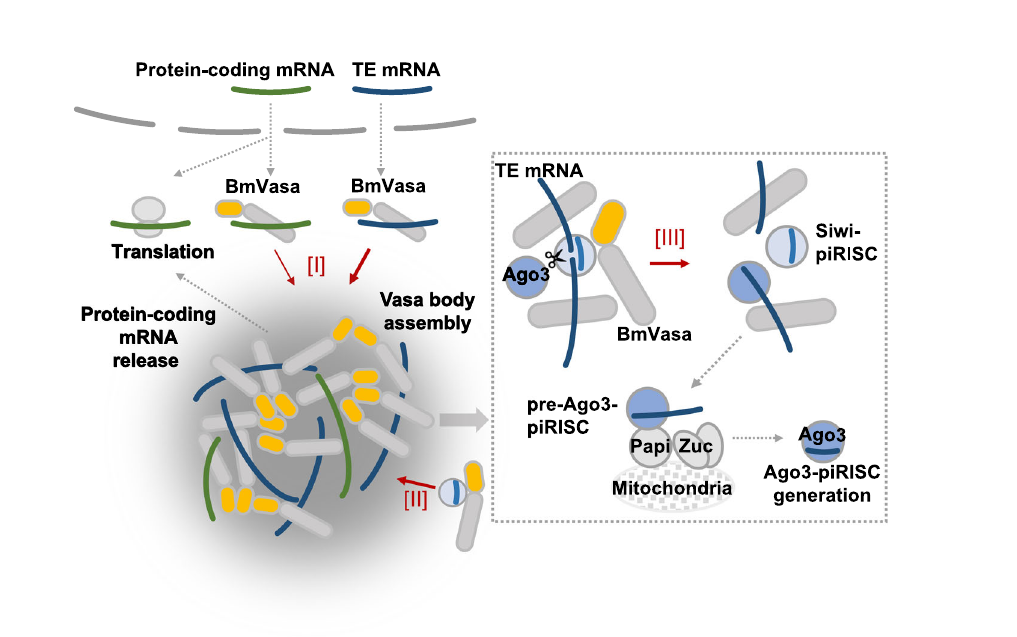
Fig.5|BmVasapreferentiallybindstotransposonmRNAsinvivo.a , b Piecharts show the proportions of transposon mRNAs (blue) and protein-coding mRNAs (green) in the total RNA sequencing library (Total; left) and in the BmVasa FAST- iCLIP library (BmVasa binding; right), both of which were individually produced in BmN4cells(Control)( a )andinBmN4cellslackingSiwi-piRISC(Siwi-piRISCKD)( b ). The association between the data is statistically signi fi cant (X 2 =56,205, df = 1, p value <2.2×10 − 16 , by Pearson ’ s chi-squared test (Two-tailed)) ( a ), (X 2 =60,140, df=1, p value <2.2×10 − 16 , by Pearson ’ s chi-squared test (Two-tailed)) ( b ). c Scatter plots show correlation between RPKM values of the total RNA sequencing library (Total) and RPM values of the BmVasa FAST-iCLIP library (BmVasa binding) for protein-coding mRNAs (green; top) or transposon mRNAs (blue; bottom). ρ is Spearman ’ s rank correlation coef fi cient. d Scatterplots(left)show RPKMvalues of the total RNA sequencing library (Total; top) or RPM values of the BmVasa FAST-